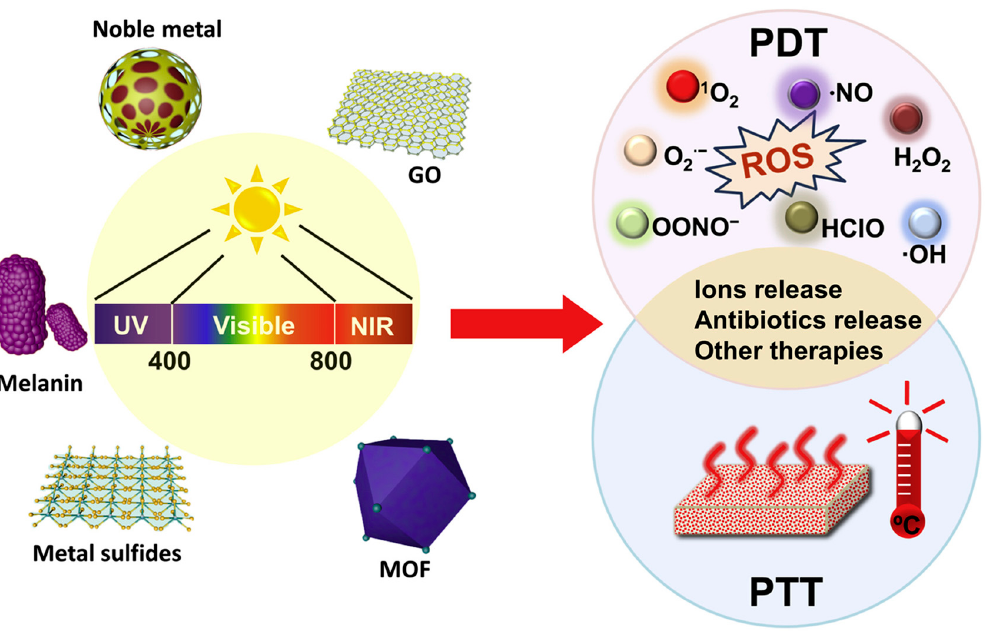
Figure 1. Schematic of photo-stimuli-responsive antibacterial materials and mechanism. Repro- duced with permission from Ref. [4]. Copyright 2020 Elsevier. with permission from Ref. [4]. Copyright 2020